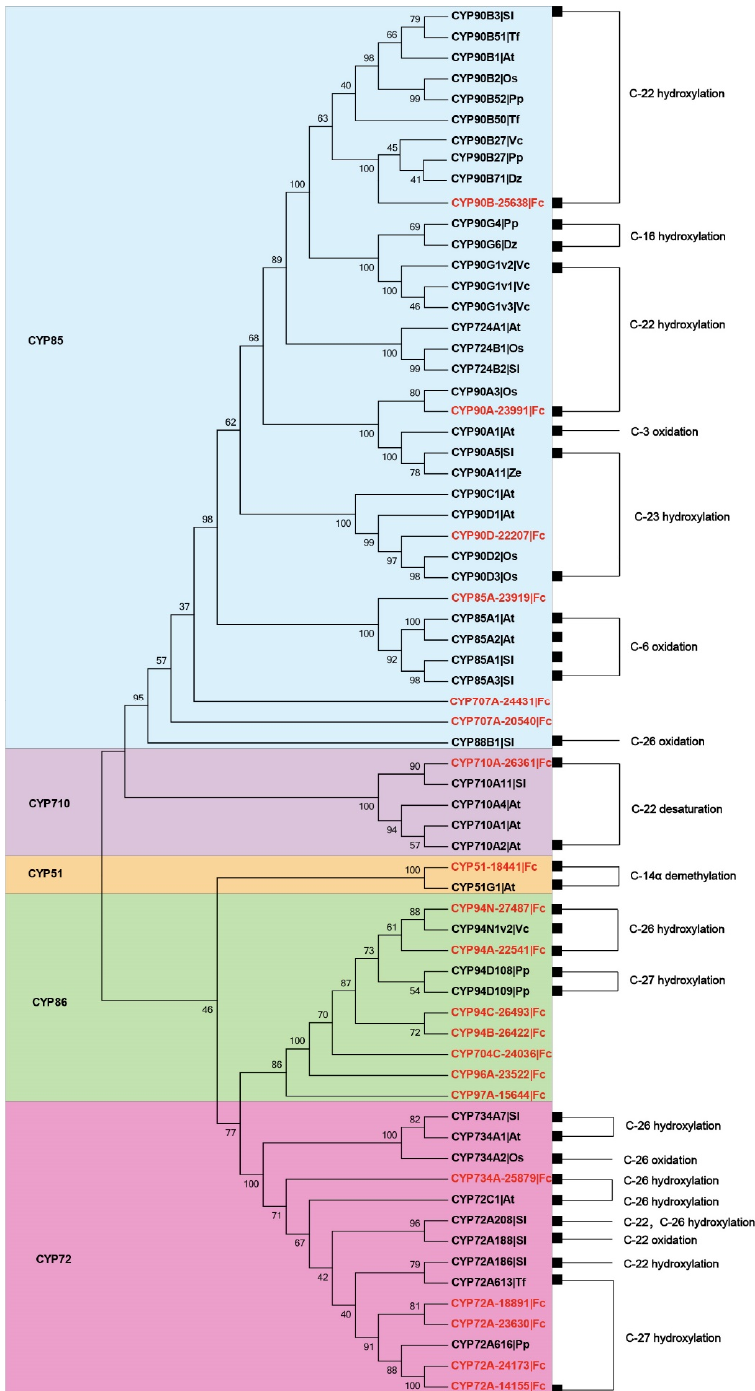
Figure 2. Phylogenetic tree of previously characterized sterol biosynthesis CYP450s and those F. cirrhosa CYP450s isolated in this study (in red). The known biochemical activities of P450s are indicated on the right.